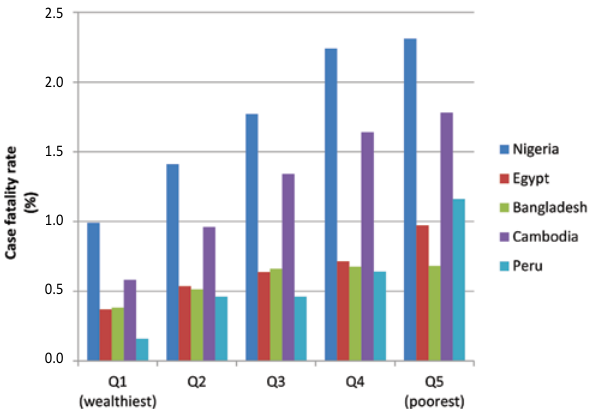
Figure 6 Case fatality rates by wealth quintiles in exemplar countries.